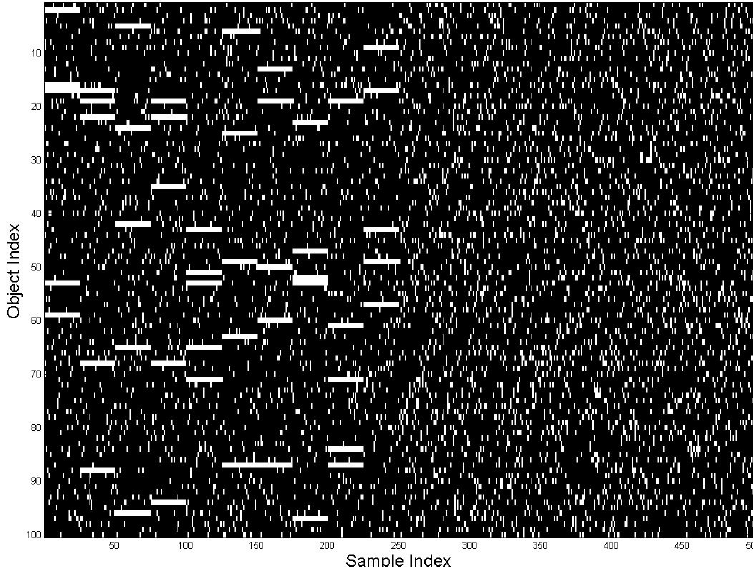
Figure 2. Generated data; object index is along vertical axes and situation index is horizontal. The perceptions (data samples) are sorted by situation index (horizontal axis); this makes visible the horizontal lines for repeated objects.